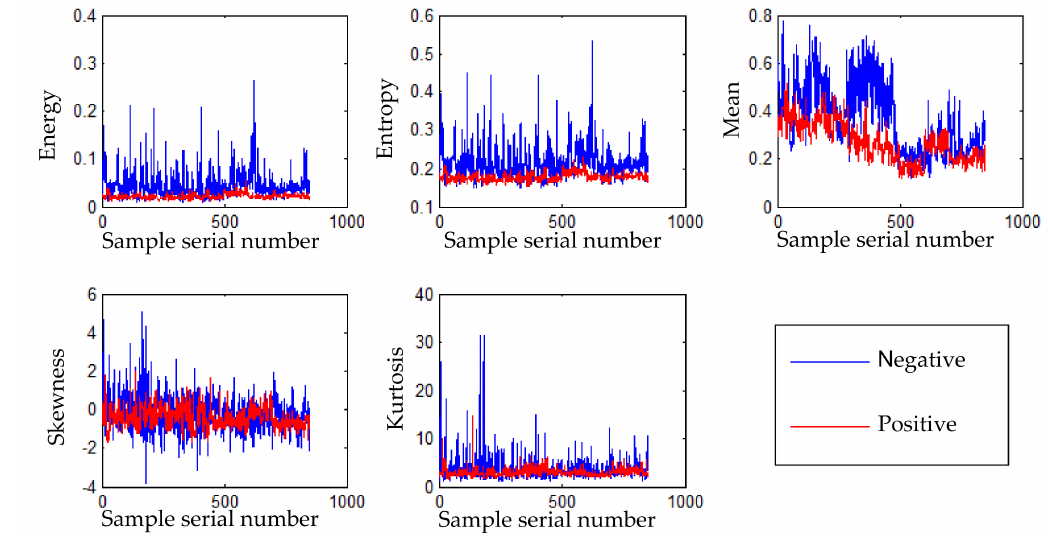
Figure 14. The first-order statistical features of the samples.